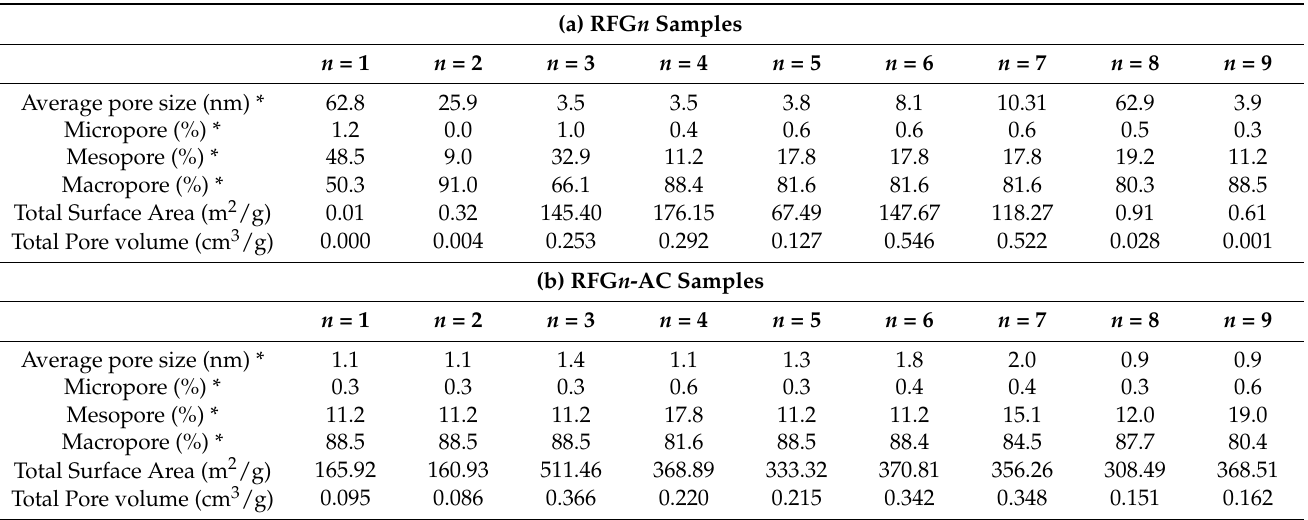
Table 5. Pore structure characteristics of (a) RFG n and (b) RFG n -AC samples (estimated from surface area and porosity analyzer from adsorption/desorption isotherms of N 2 gas at 77